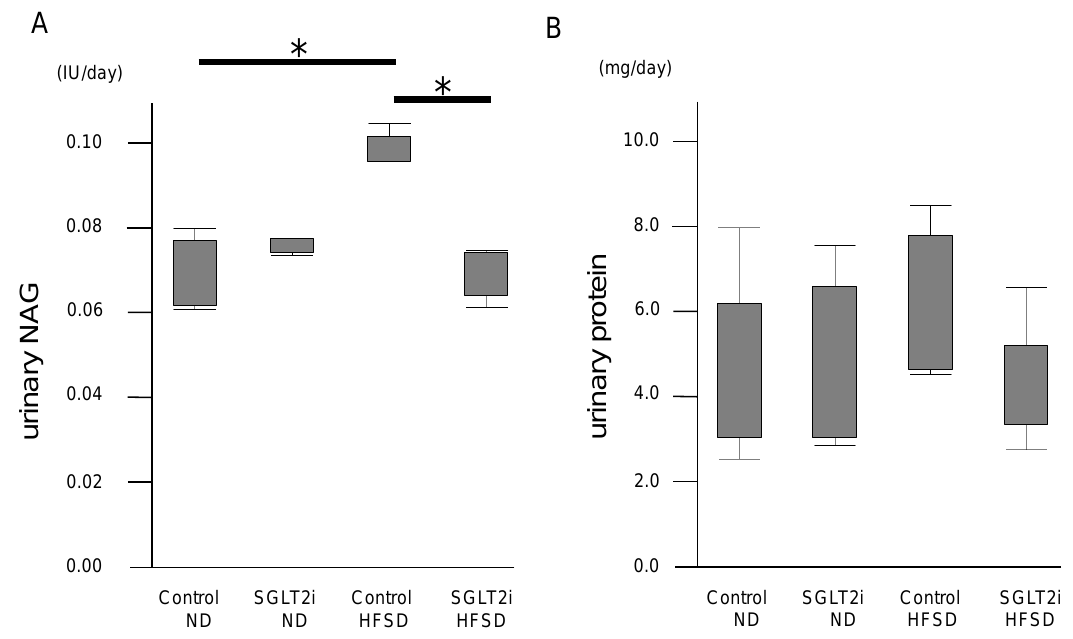
Figure 8. SGLT2inhibitor(SGLT2i)decreasedtheamountofurinary N -acetyl-beta- d -glucosaminidase(NAG) independent of urinary proteins. The amount of ( A ) urinary NAG and ( B ) protein. The urine was collected for 24 h one day before sacrifice. Results are presented as the mean ± standard deviation. Differences were evaluated by two-way ANOVA followed by Tukey–Kramer test (* p < 0.05). SGLT2i: